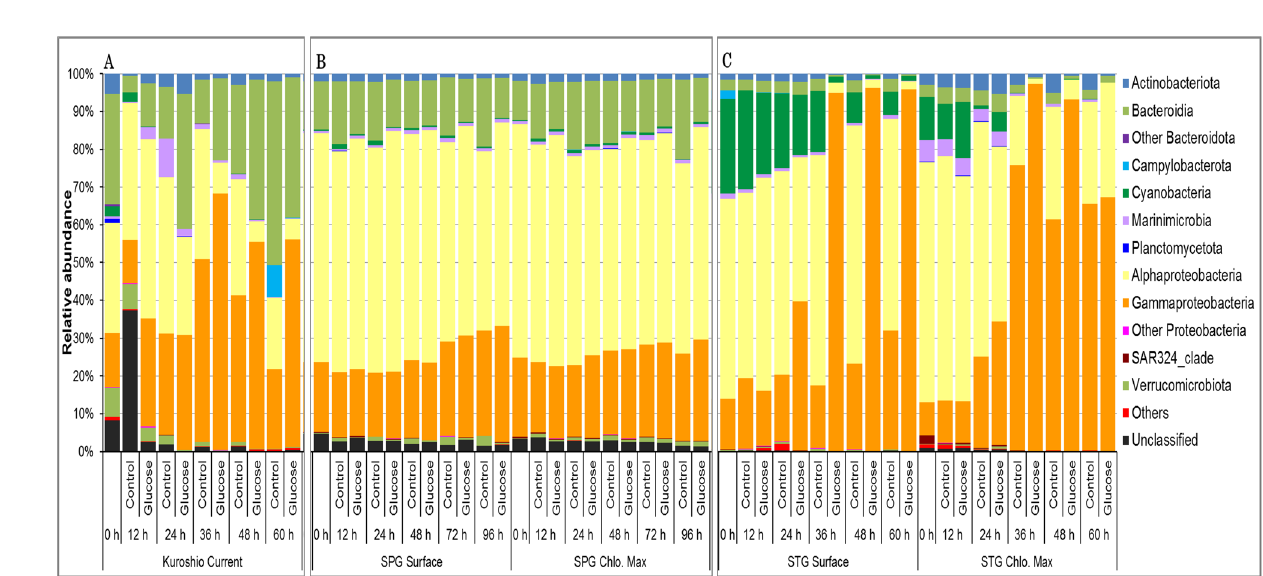
Figure 2. Changes of bacterial community structure during the shipboard microcosm experiments with the water collected from the ( A ) Kuroshio Current, ( B ) North Pacific Sub-polar Gyre (SPG), and ( C ) North Pacific Sub-tropical Gyre (STG) in the western North Pacific Ocean during the KH-14-2 cruise in May–June